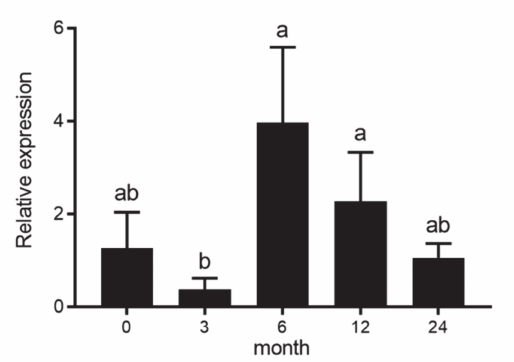
Figure 1. The mRNA expression level of deleted in azoospermia-like (DAZL) during testicular development. Di ff erent letters above error bars indicate significant di ff erences, p < 0.05. Same as